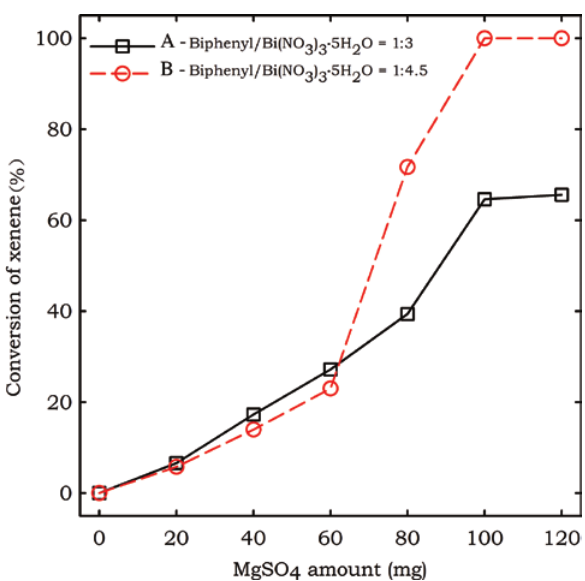
amount on the conversion of 4